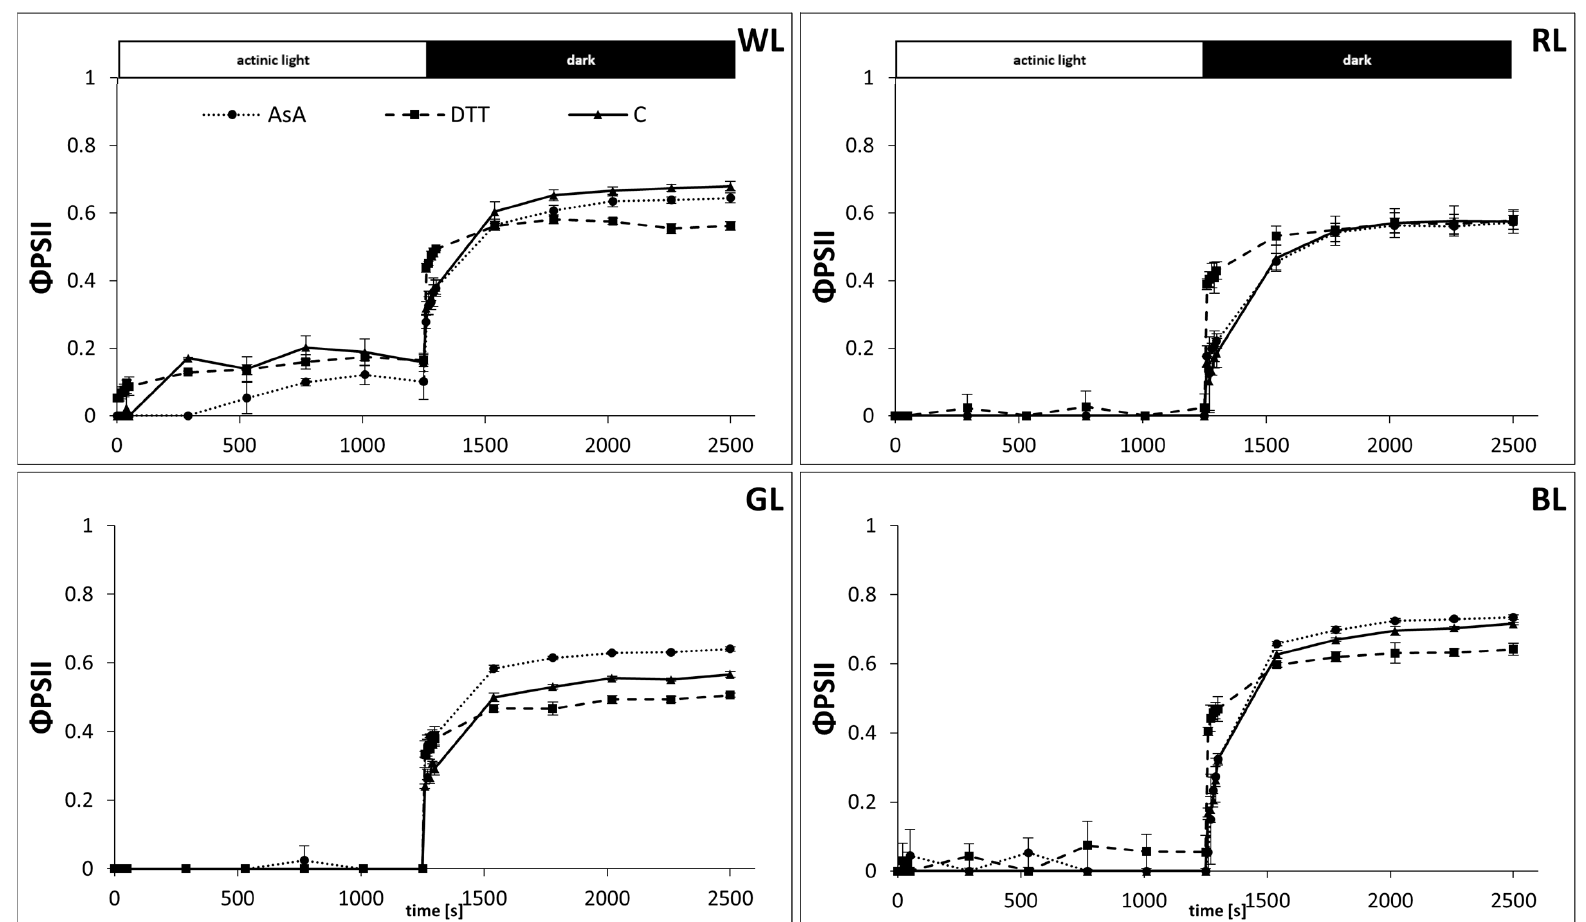
Figure 5. Measurement of the effective quantum yield of PSII, Φ PSII, in leaves of tomato plants ( Solanum lycopersicum L. cv. Malinowy Ozarowski) grown under different light conditions (see Material and Methods for details). 10 mm diameter leaf discs were infiltrated with 10 mM ascorbic acid (AsA) or 5 mM dithiothreitol (DTT), or distilled water (C, control) for 30 min in the dark, followed by pre-illumination at 500 µmol m − 2 s − 1 of RGB light for next 30 min. The dynamics of the Φ PSII were determined in re-darkened leaf samples illuminated for 20 min at 185 µmol m − 2 s − 1 of blue actinic light (AL = 450 nm) (induction), followed by 20 min of dark incubation (relaxation), and derived from the maximum fluorescence induced by saturation pulses (5000 µmol m − 2 s − 1 , 0.8 s) at each of the measuring points ( Φ PSII = (Fm’ − F)/Fm’). Each data point represents the average ± SD of six independent measurements ( n = 6).